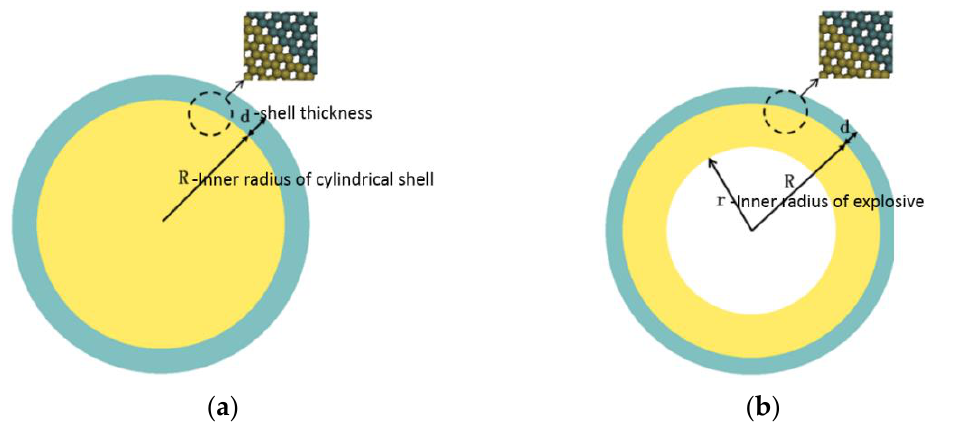
Figure 2. SPH numerical model: ( a ) JOB9003 packing (R = 30 mm) and ( b ) RHT-901 hollow packing (R/r = 30 mm/20 mm).